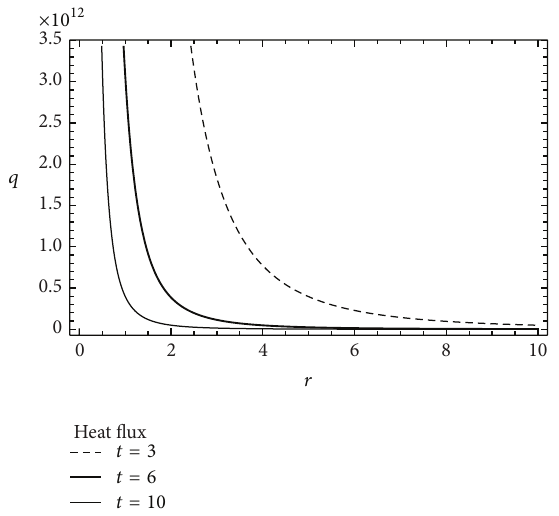
Figure 5: The radial profile for the heat flux 𝑞 at various units of